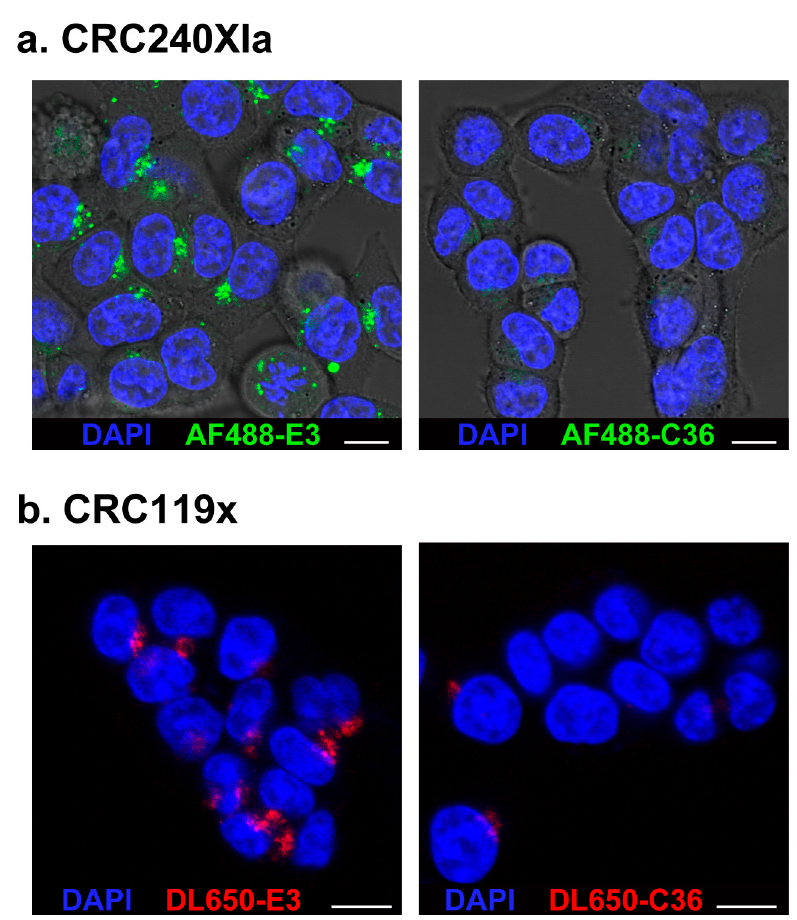
Figure 3. Confocal microscopy confirms E3 aptamer internalization into PDX-derived cancer cells. Cells were treated for 1 h with ( a ) 10 μ M of AF488-E3 aptamer or AF488-C36 control aptamer or ( b ) 1 μ M of DL650-E3 aptamer or DL650-C36 control aptamer. After washing, Hoechst 33342 was added to all samples to stain the nuclei. Cells were imaged on a Leica SP5 inverted confocal microscope. (White scale bars: 10 μ m)